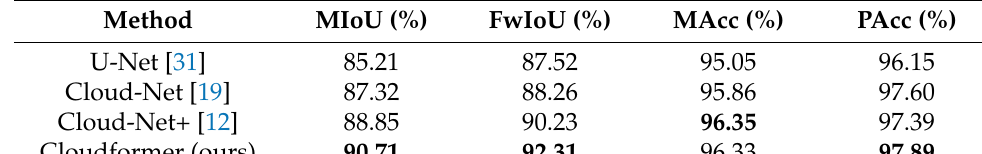
Table 5. Comparison of different cloud-detection methods on 38-Cloud.